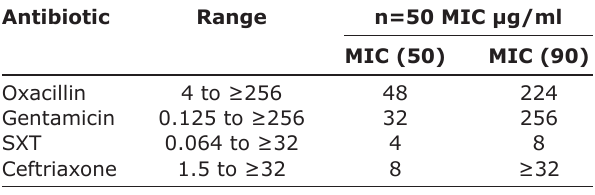
Table-3: MIC of MRSA isolates to four antibiotics.